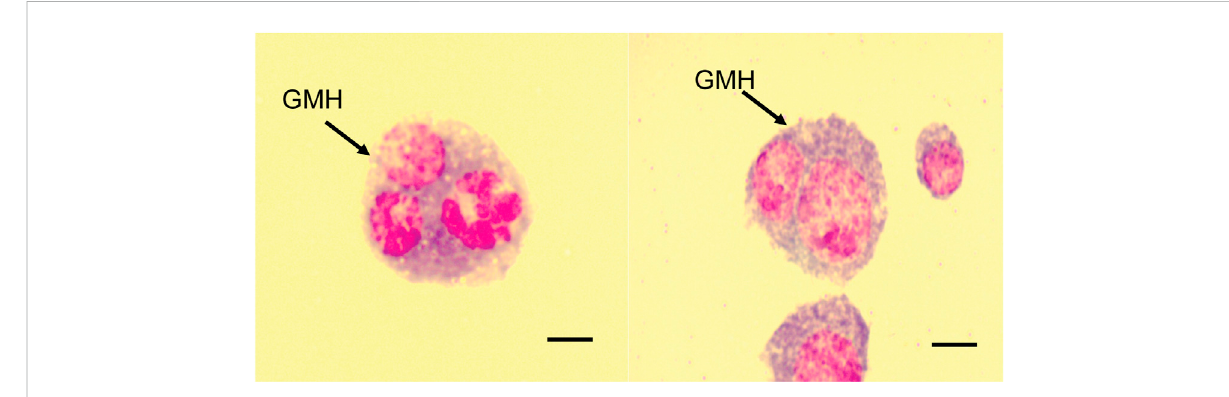
FIGURE 5 Giant multinucleated hemocytes of parasitized B. dorsalis host larvae. Scale bar = 10 μ m.